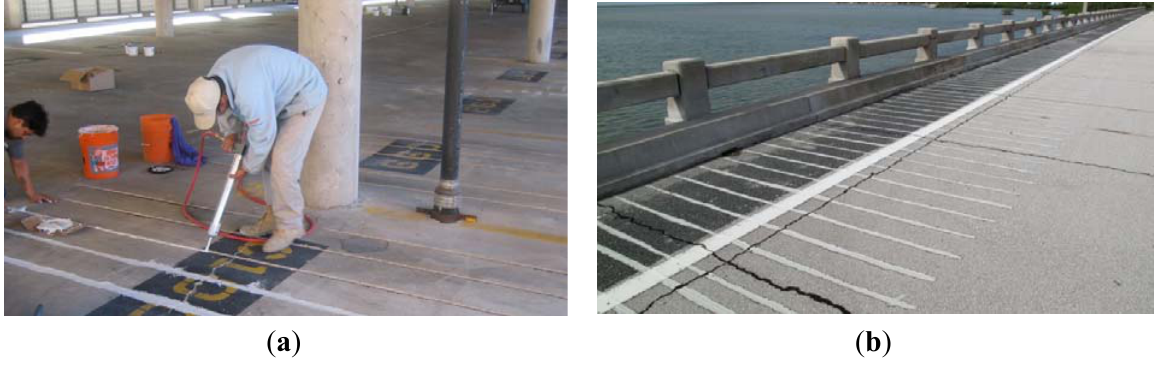
Figure 25. Near-surface-mounted (NSM) FRP installation on negative moment regions: ( a ) Exposed concrete slab in a parking garage; ( b ) Concrete below the asphalt overlay in the cantilevered portion of a bridge deck.